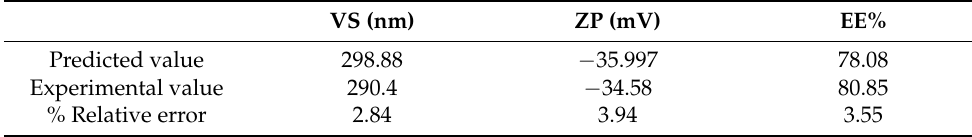
Table 4. Validation of the optimum